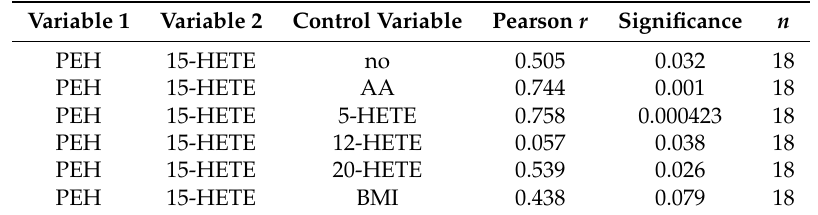
Table 3. Semi-Partial Correlation of PEH with fold-changes of 15-HETE and possible confounders + 10 min after cessation of exercise.